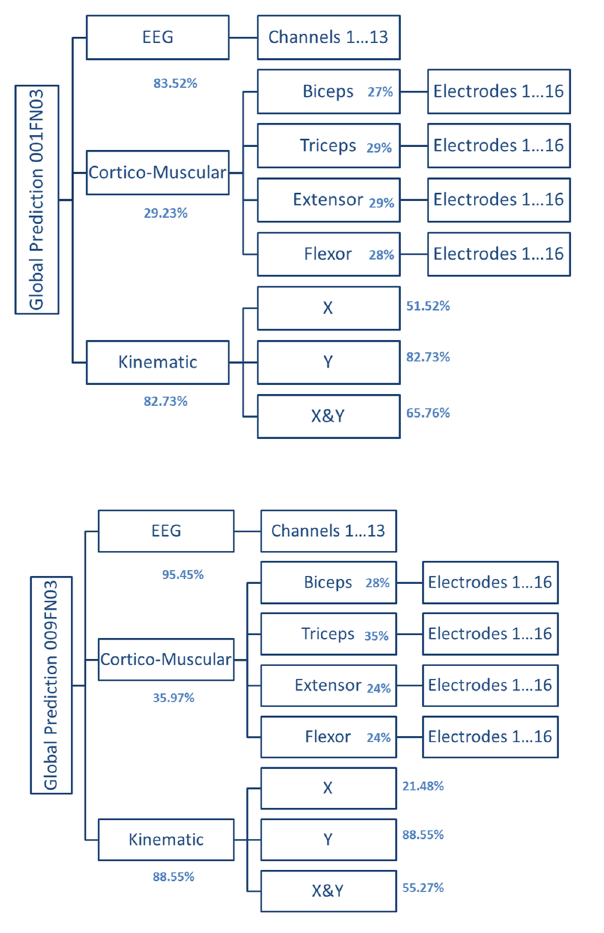
EEG, EMG, accelerometer and gyroscope data for a FES- mediated brain-computer interface (BCI) aiming to suppress neurological